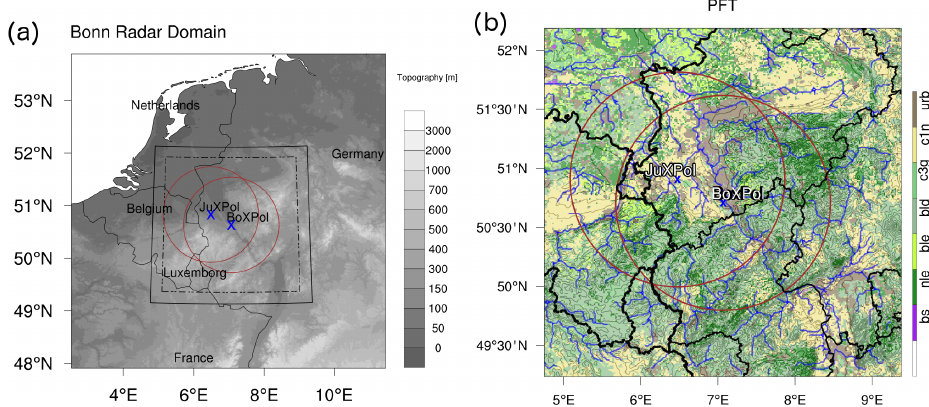
Figure 2. (a) Spatial pattern of topography and extent of Bonn radar domain (solid line) including the coverage of BoXPol and JuXPol (red circles). The dotted lines indicate the inner domain (excluding the relaxation zone) used to compute the domain average precipitation. (b) Spatial pattern of plant functional types (PFTs). Also shown is the coverage of two X-band